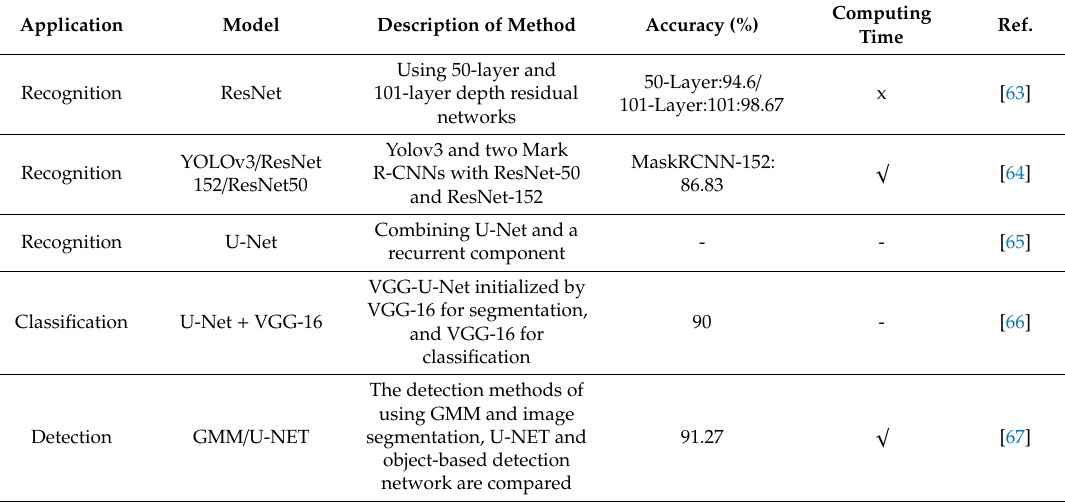
Table 2. Applications of deep learning networks in dense images in di ff erent agricultural